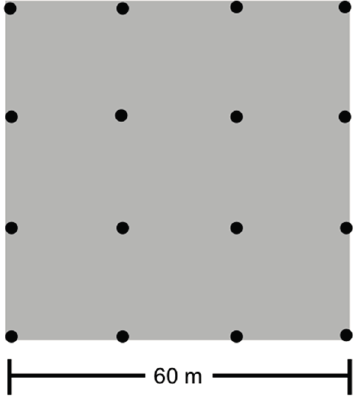
Figure 5. Schematic diagram of the arrangement of temperature data loggers at each 60 × 60 m grid cell footprint. Data loggers are indicated by black